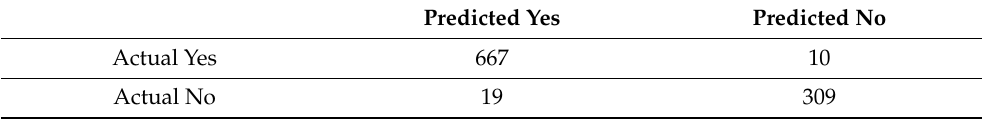
Table 14. Logistic regression confusion